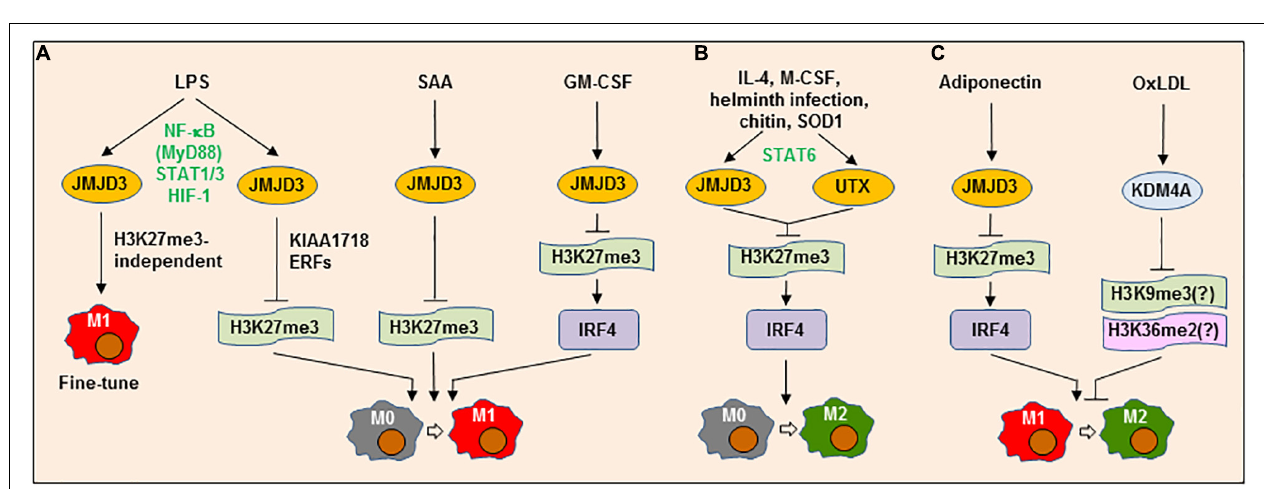
FIGURE 1 | Different lysine methyltransferases may play opposite roles of in macrophage polarization and functions. (A) H3K4me3 mediated by lysine methyltransferases (KMTs e.g., KMT2A/MLL) is involved in oxLDL-induced training immunity of monocytes (Mo) in atherosclerosis (AS) and LPS-induced M1 polarization. (B) High-fat diet (HFD) induces the expression of TRPA1 (a calcium permeable non-selective cation channel), which stabilizes EZH2 (PRC2 or KMT6) to inhibit M1 polarization via H3K27me3. (C) LPS and IFNs up-regulates SETDB2 via IRF7, while deletion of SETDB2 in hematopoietic cells promotes M1-like polarization and impairs efferocytosis, a function of M2 macrophages, via H3K9me3 in AS lesions. oxLDL, oxidized low-density lipoprotein; LPS, lipopolysaccharide; TRPA1, transient receptor potential ankyrin 1; EZH2, enhancer of zeste homolog 2; IFN, interferon; IRF7, interferon regulatory factor 7; SETDB2, SET domain bifurcated histone lysine methyltransferase 2.